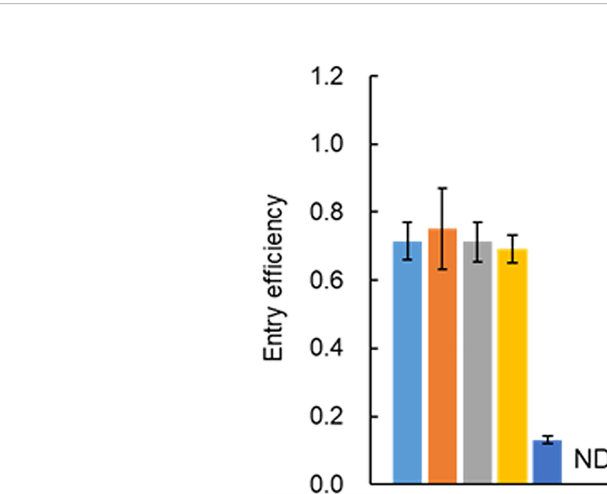
and the difference in the ef fi cacy of genome damage by UV wavelengths. This result may explain why a higher level of energy dose of UV at 300 nm is required for HIV-1 inactivation. In conclusion, the results demonstrated that